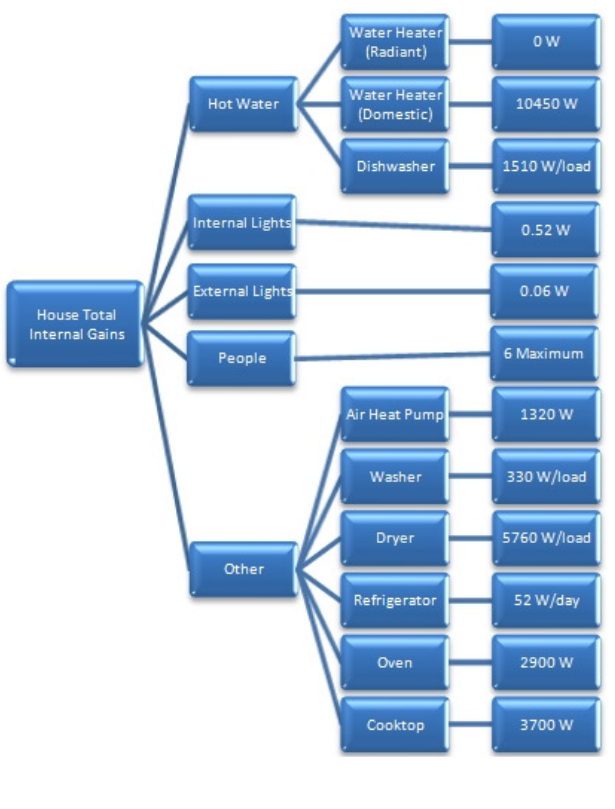
Figure 2. Summary of loads for Team Missouri’s 2009 solar